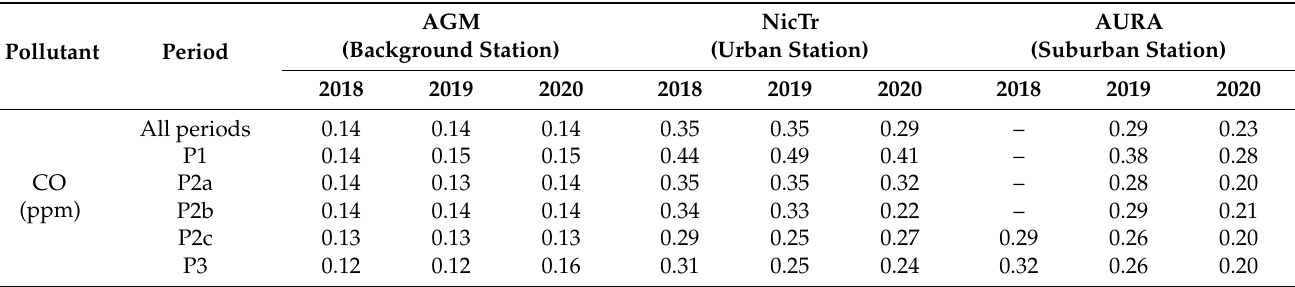
Table 5. The period averages for AGM, NicTr station and AURA station for 2018, 2019 and 2020.